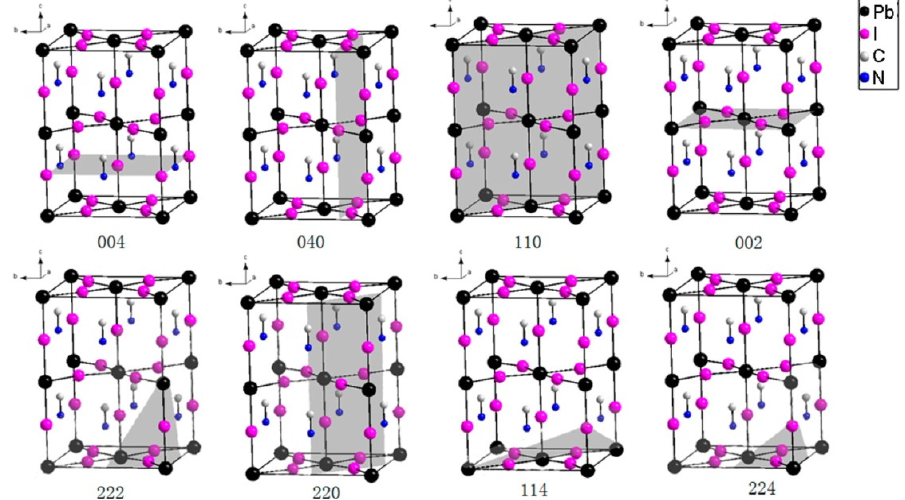
Figure 3. Crystallographic (lattice) planes (in gray) of tetragonal MAPbI3. Reprinted from reference [78], Copyright © 2015, American Chemical Society.